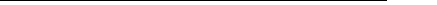
when the contribution to the total DM relic density from DM production for T > T sizable. In (cid:12)gure 2 we show the DM relic density with the inclusion of thermal corrections (cid:10) h 2 and the corresponding DM relic density when these are disregarded 11 (cid:10) h 2 TC well as the partial contributions before and after the EW phase transition, as a function of m 2 for m 1 = 1 GeV and T EW = 50 GeV (left panel), T EW = 100 GeV (middle panel) and T EW = 160 GeV (right